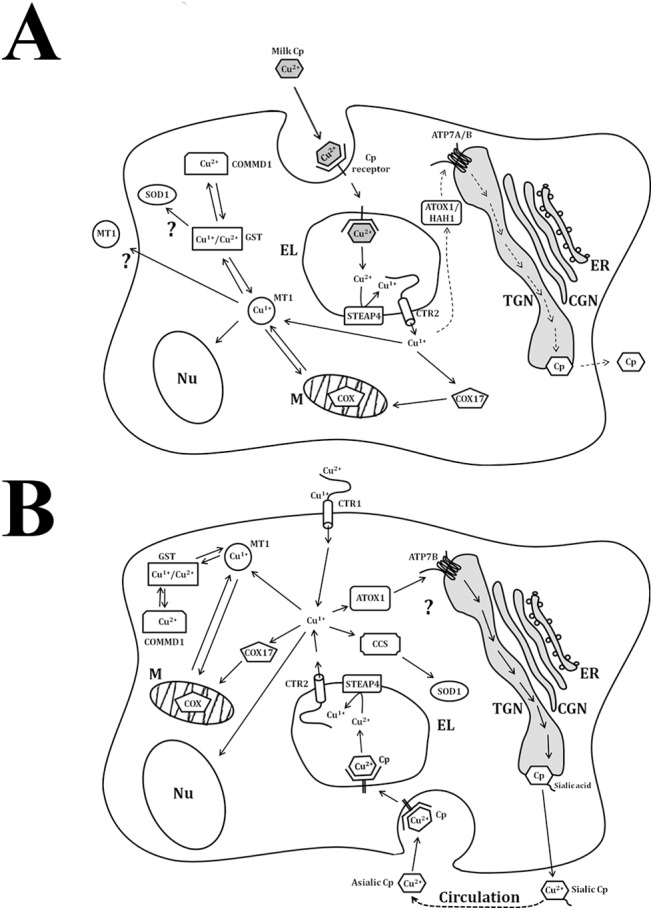
Schema illustrating copper turnover in the hepatocytes newborns (A) and adults rats (B).(A) In newborns, milk Cp enters to gastrointestinal tract and due to transcytosis transfers into bloodstream, and then it binds with hepatic Cp receptor and proceeds into endolysosomes (EL). At pH > 5, Cu(II) ions are dissociated from milk Cp molecule, Cu(II) is reduced to Cu(I) by STEAP4 and imported by CTR2 in cytosol. Here, Cu(I) is redistributed between Cu(I)-chaperons to be delivered to the places of apo-cuproenzymes formation (trans Golgi network (TGN), cytosol, mitochondria (M)). Also copper is bound with MT, and involved to redox cycle MT/glutathione or delivered to nucleus (Nu) and M as well as exported to extracellular space. As MT is found in mitochondria and nucleus [40], possibly, it transferred copper to the nucleus and mitochondria (or brings copper to their cytosolic surface). (B) In adults, absorbed nutrient copper is imported by CTR1 and distributed between Nu, M, cytosol, and MT [5]. Copper of disturbed cuproenzymes can be re-cyclized via endocytosis or autophagy. In both cases, the copper return in metabolic cycle through STEAP4/CTR2 endolysosomal system.